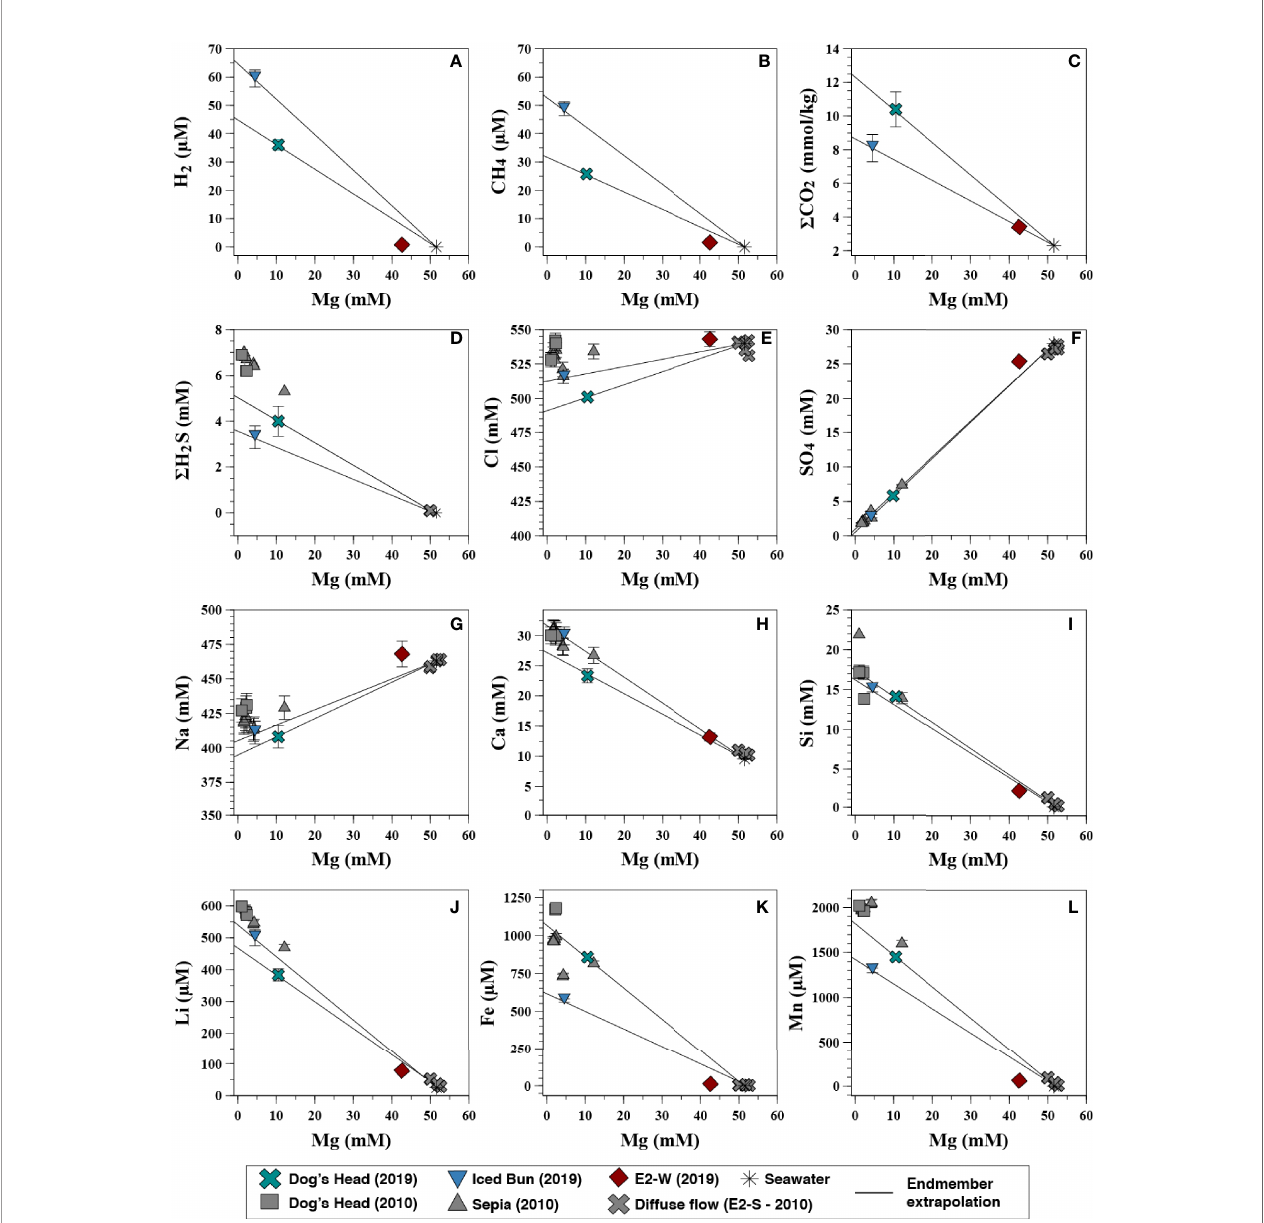
FIGURE 4 | Concentrations of dissolved volatiles, major and minor elements in the fl uids recovered from E2 in 2019 (coloured) v/s Mg concentrations of the hydrothermal fl uids. Concentrations of fl uids sampled in 2010 by James et al. (2014) (Grey) are shown for comparison. The solid lines indicate linear regression to endmember composition. The analytical error bars are shown or are smaller than the symbols. (A) H 2 vs Mg, (B) CH 4 vs Mg, (C) CO 2 vs Mg, (D) H 2 S vs Mg, (E) Cl vs Mg, (F)